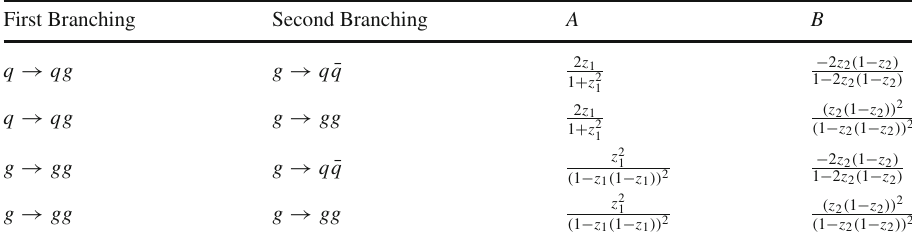
First Branching Second